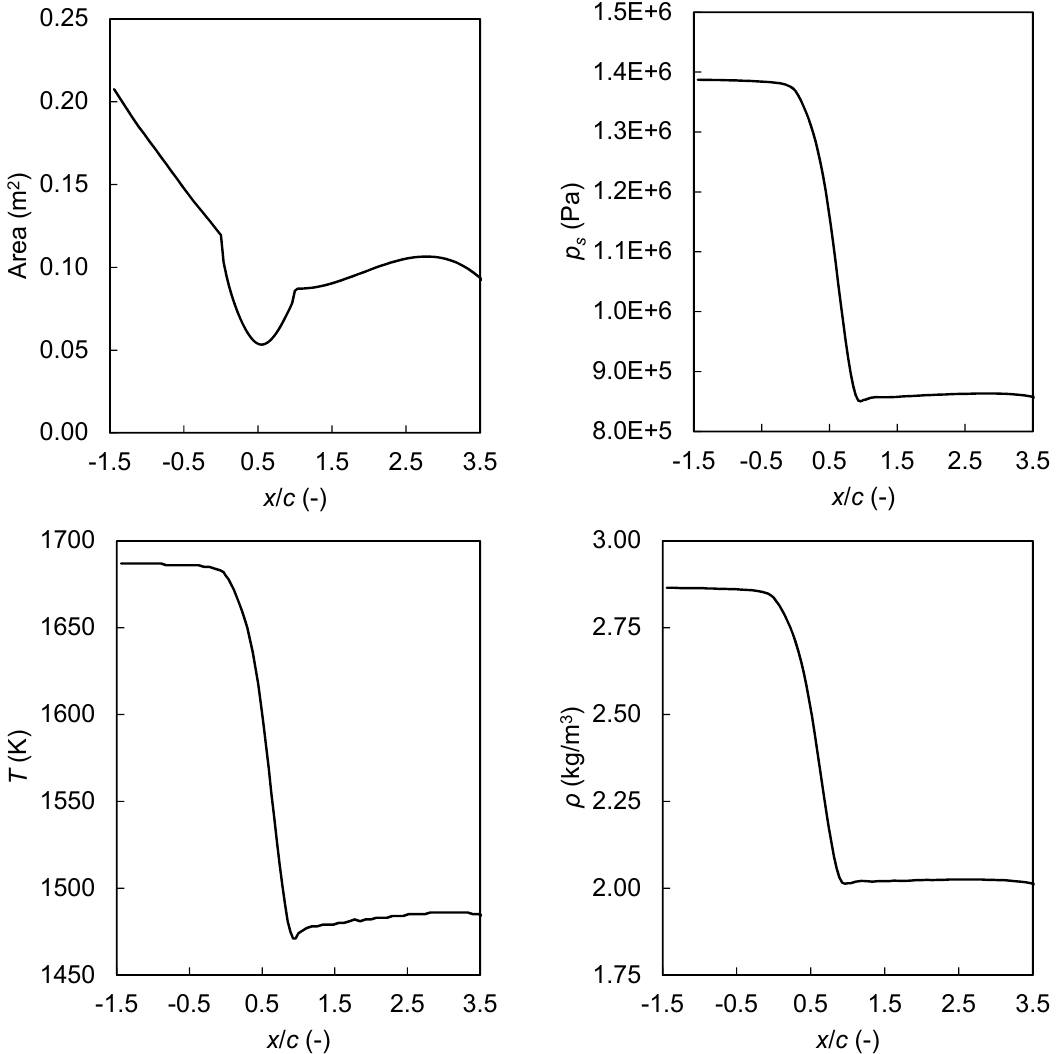
Figure 7. Profiles of cross-sectional area, static pressure, temperature and density imposed to the CRN for conditions C and D (cruise).